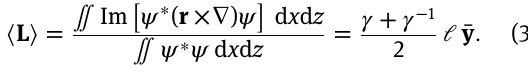
distribution over k can provide localization along the y y -axis. The real-space form of the STVP (1) is given by the Fourier integral 𝜓 ( r , t ) ∝ ∬ ̃𝜓 ( k ) e i k ⋅ r − i 𝜔 ( k ) t d k